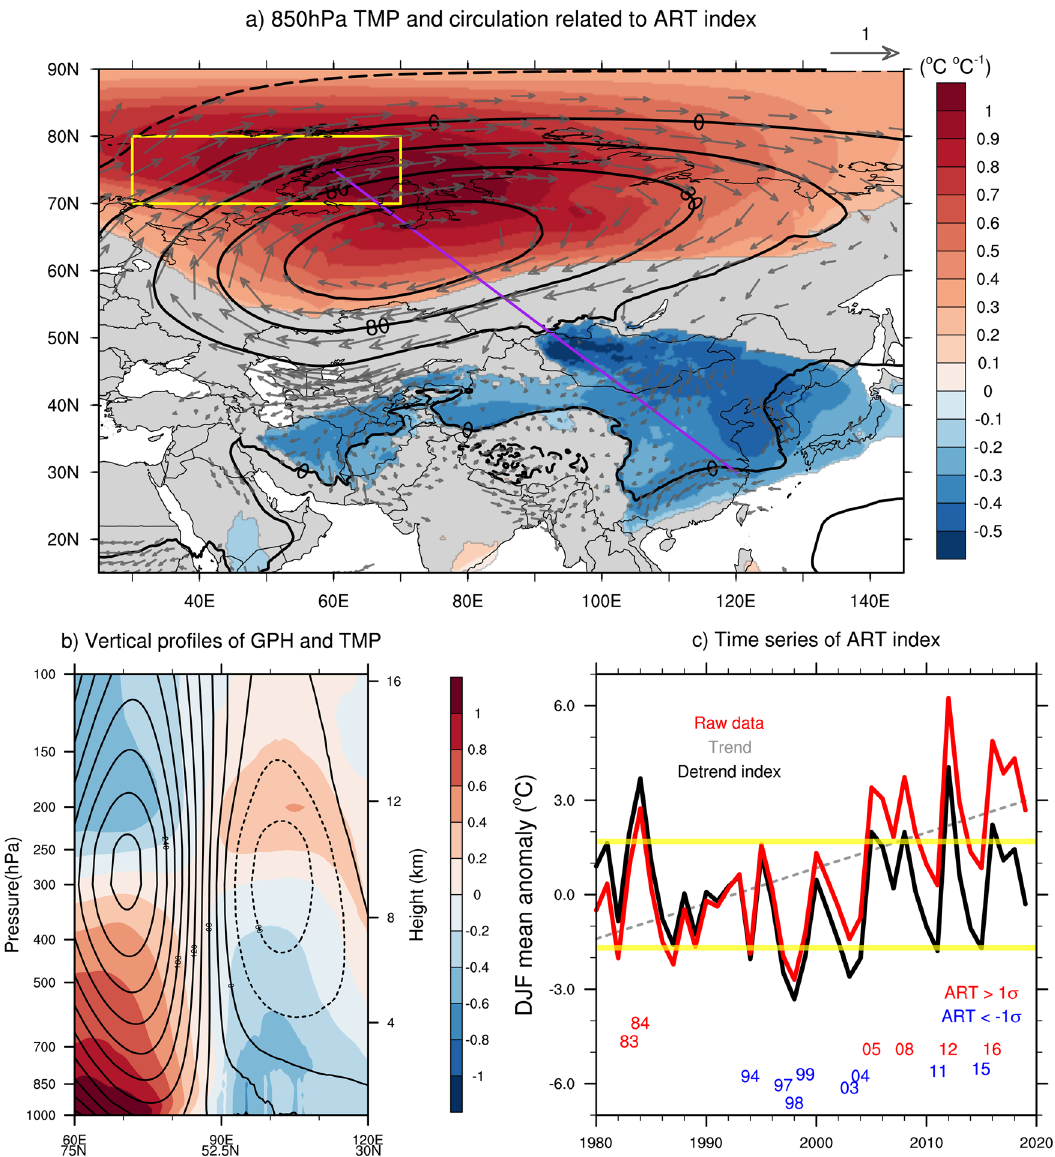
Fig. 1 Barents-Kara Sea temperature variability and relevant teleconnection. a Regression coef fi cients of December – February averaged 2-meter temperature (°C °C − 1 ), 850-hPa geopotential height (m °C − 1 ), and wind (m s − 1 °C − 1 ) onto de-trended Barents-Kara Sea (yellow box; 30° – 70°E, 70° – 80°N) temperature anomaly (ART index). Wind vectors and shading are displayed only in signi fi cant regions at the 95% con fi dence level (calculated using a Student ’ s t -test). b Time series of raw ART index and de-trended index. Yellow lines show ±1 σ and Arctic warming (>1 σ ) and cooling (< − 1 σ ) years are marked. c , Regression coef fi cients of vertical pro fi les of geopotential height (m; contour) and temperature (°C, shaded) from 1000-hPa to 100-hPa along 60°E, 75°N – 120°E, 30°N (the diagonal purple line in a